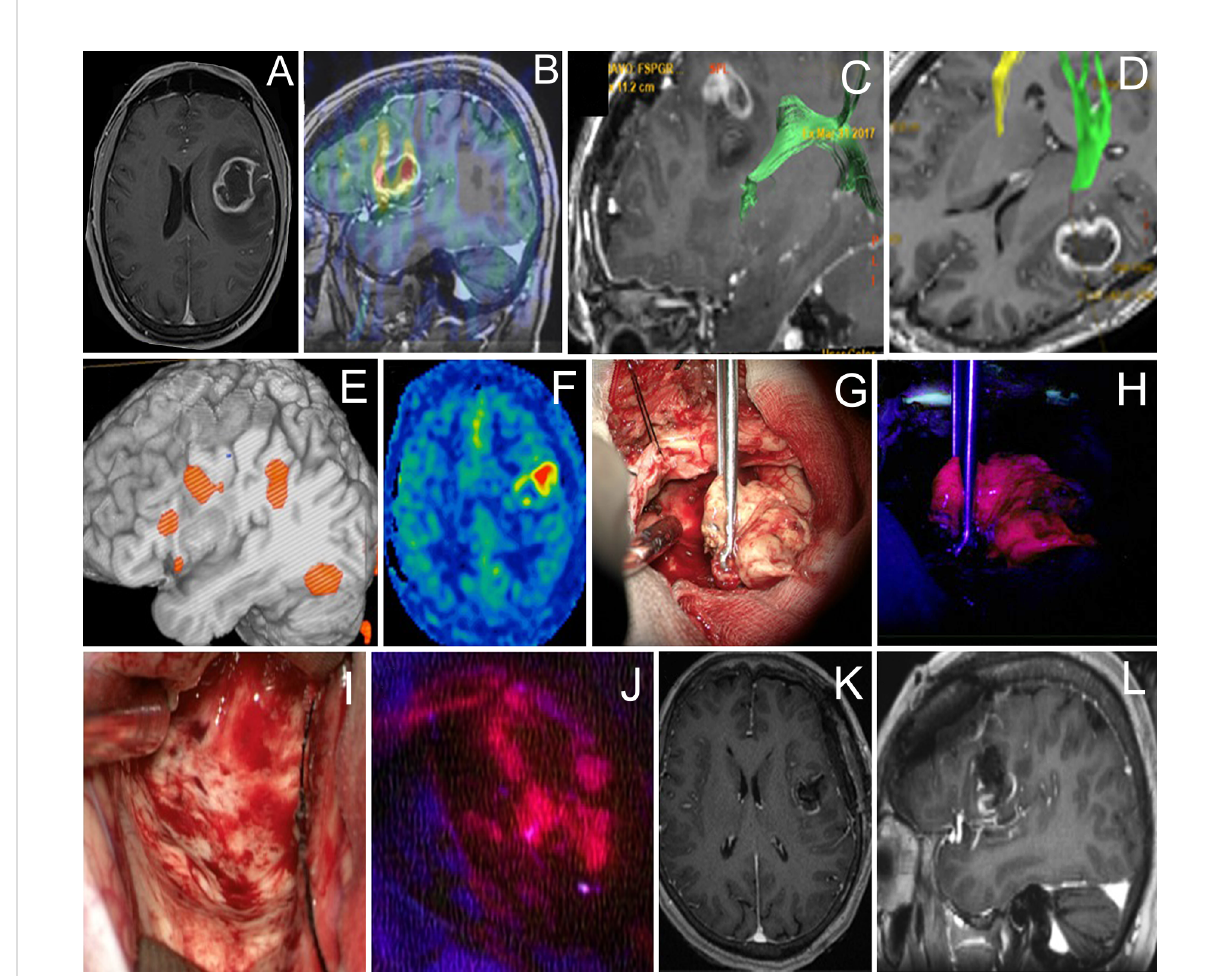
FIGURE 2 Case 2. A 61-year-old woman with the left frontal glioblastoma located in the Broca ’ s area astrocytoma with mild residual fl uorescence at the end of resection. Axial contrast-enhanced MR image (A) and sagittal MR image superimposed on an ASL perfusion map (B) , and MR tractography showing proximity of the arcuate fasciculus ( green in C) and pyramidal ( green in D) . Functional MR image demonstrates proximity of the Broca ’ s area (E) . ASL perfusion demonstrates an increased tumor blood fl ow (F) . Intraoperative photo (G) of the main tumor bulk that showed bright fl uorescence (H) . Intraoperative photo of the tumor cavity after tumor resection was stopped due to perseverations developed upon monopolar subcortical stimulation (I) . Residual fl uorescence is seen in the part of the tumor cavity (J) . Postoperative axial (K) and sagittal (L) contrast-enhanced T1-weighted MR images demonstrate gross total removal of the contrast enhancing tumor